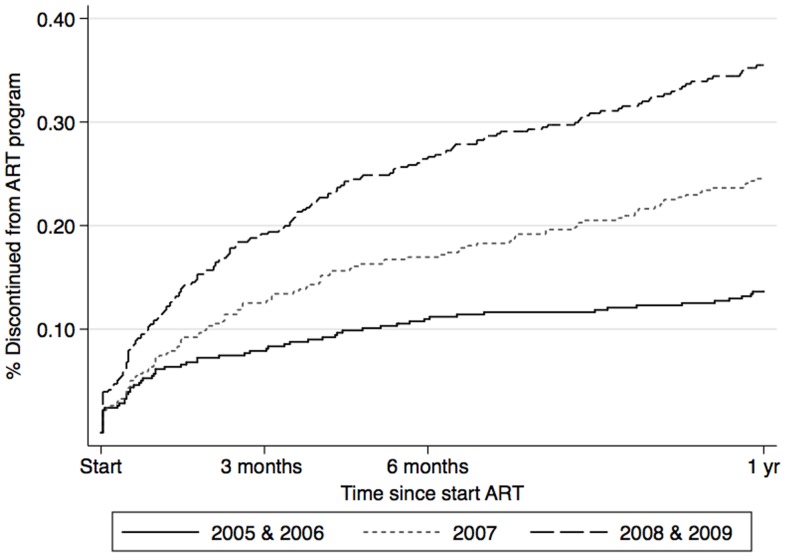
Probability of discontinuing from the AmoCongo ART program at 1 year over time by calendar year.